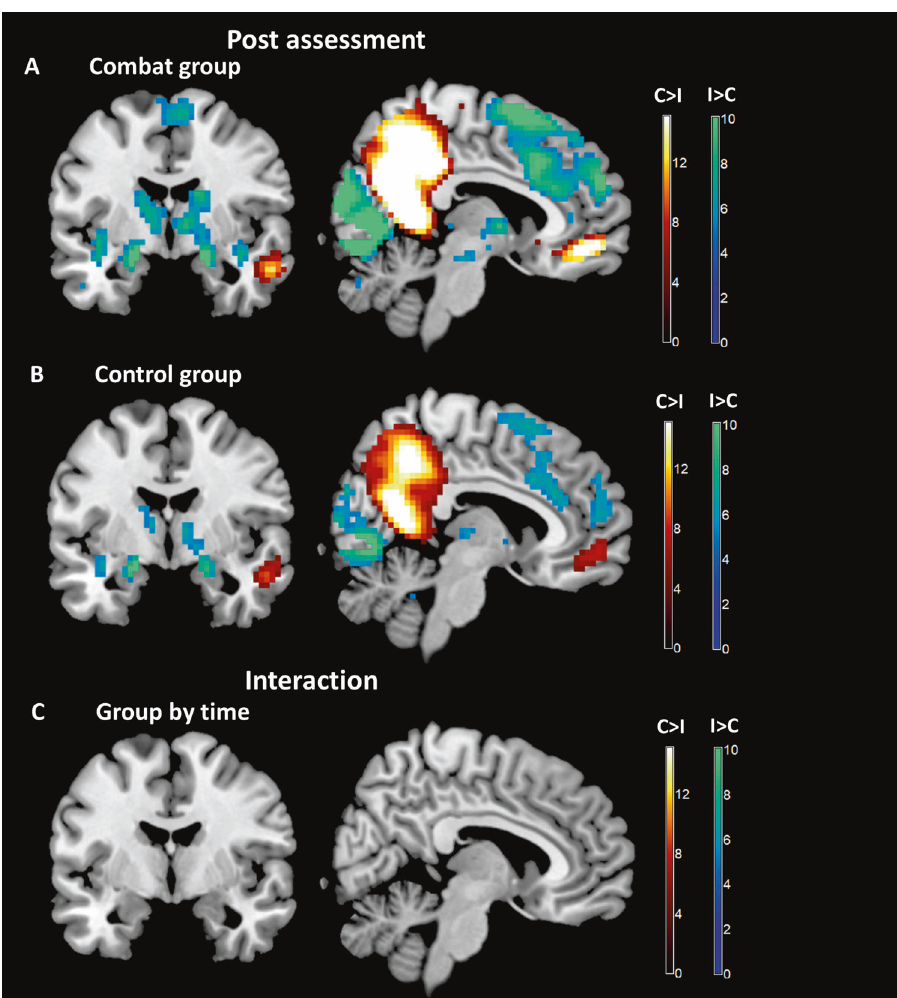
Fig. 2 Imaging results, posttest for each group and group by time interaction. A , B Very similar differential effects between processing of combat versus negative affective IAPS stimuli were observed in the combat and control group. C Group (combat vs. control group) by time (pretest versus posttest) interaction revealed no signi fi cant